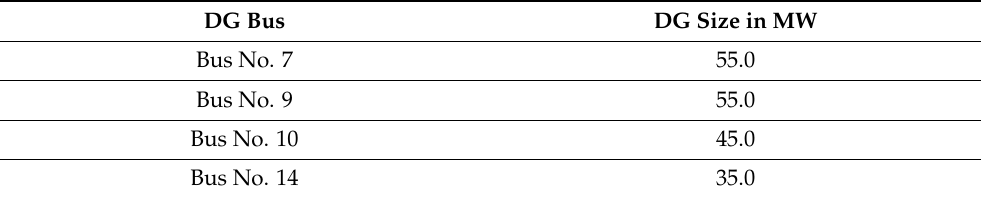
Table 8. Optimal Sizes of local generators or DGs with bus numbers for the 14-bus system of IEEE. DG Bus DG Size in MW Bus No.